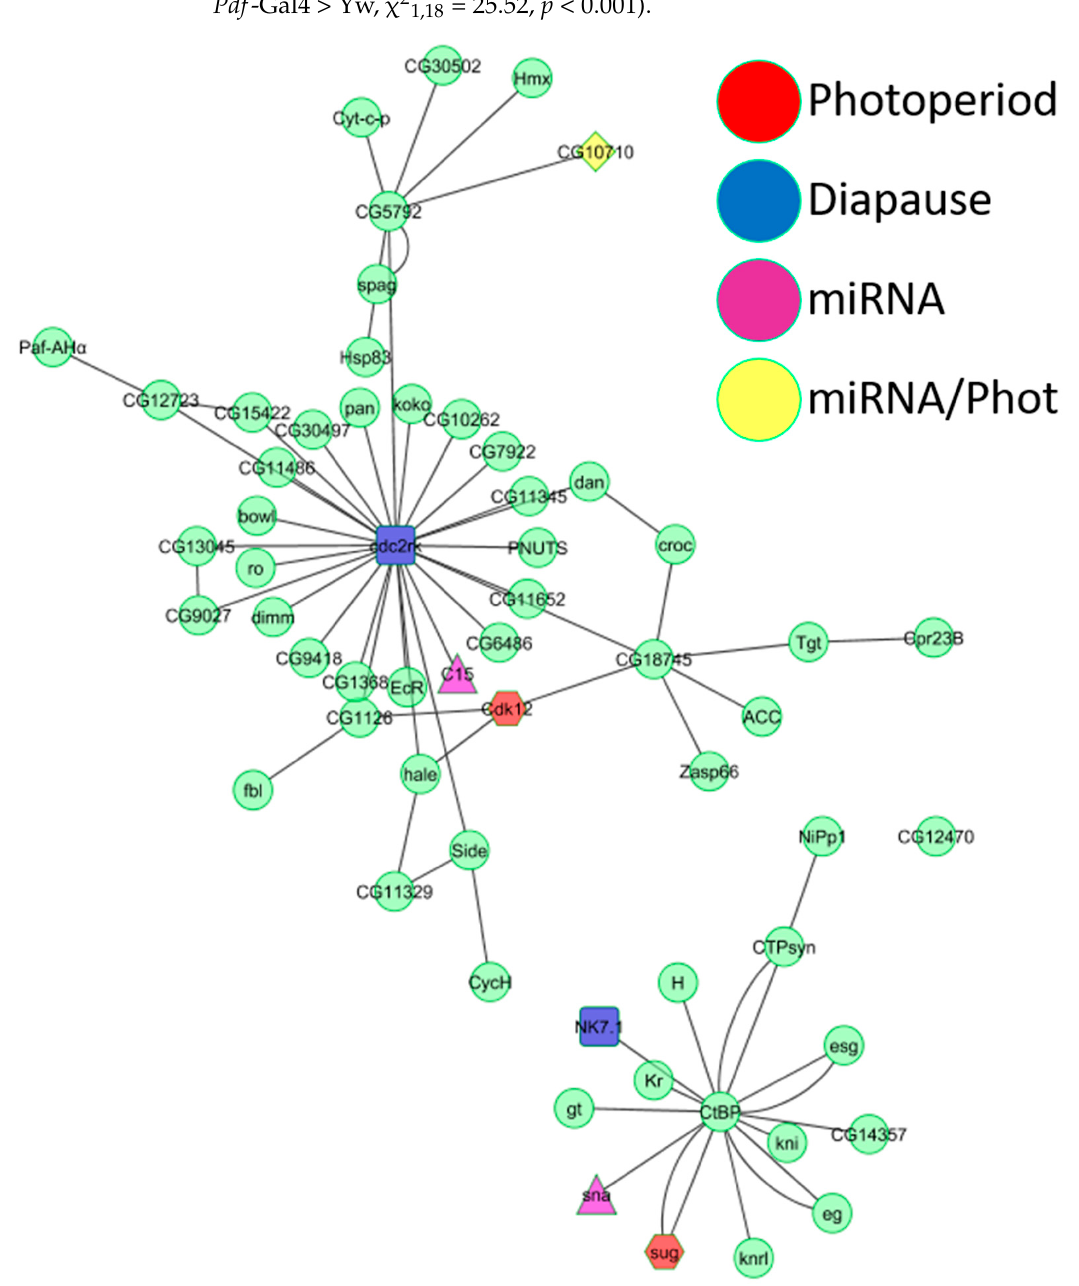
Figure 3. Intersection of yeast two-hybrid interaction networks. The intersection of the three yeast two-hybrid interaction networks (diapause, photoperiodic, and miRNA) resulted in two interaction pathways. The largest interaction pathway ( top ) has at its center at cdc2-related-kinase , a diapause DEG (Table S1). The second interaction pathway has at its center at the gene for the C-terminal-binding protein . Red nodes are photoperiodic DEGs, light blue nodes are diapause DEGs, purple nodes are DEMs targets, and yellow nodes are both DEMs targets and photoperiodic DEGs.